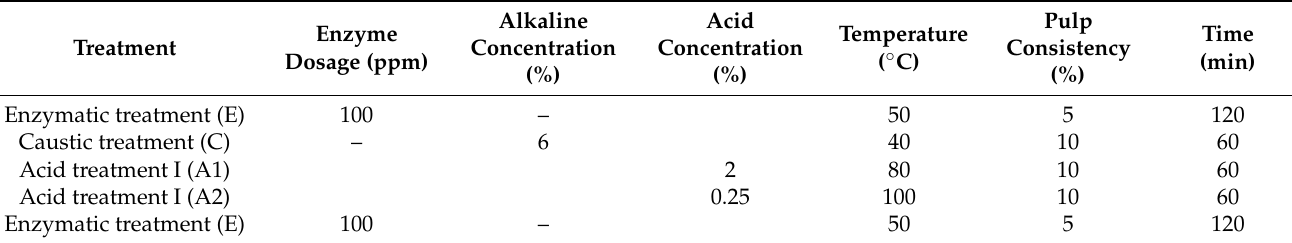
Table 1. The parameters of treatments.